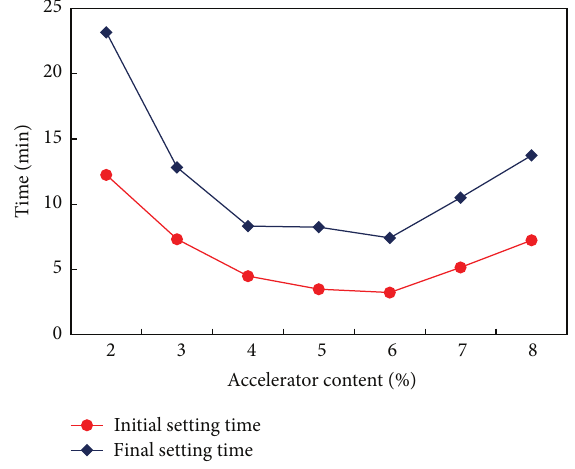
Figure 2: Effect of accelerator mass content on setting